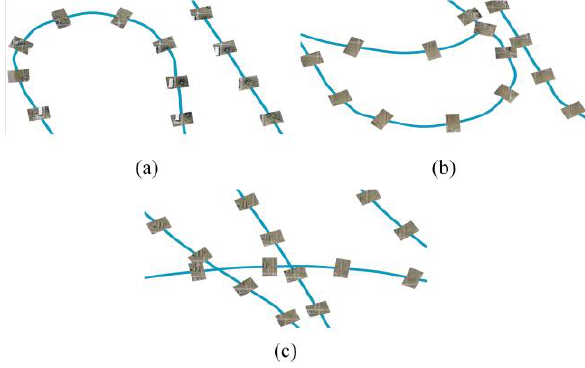
Figure 8 Tracking map with thumbnail photos rotated.